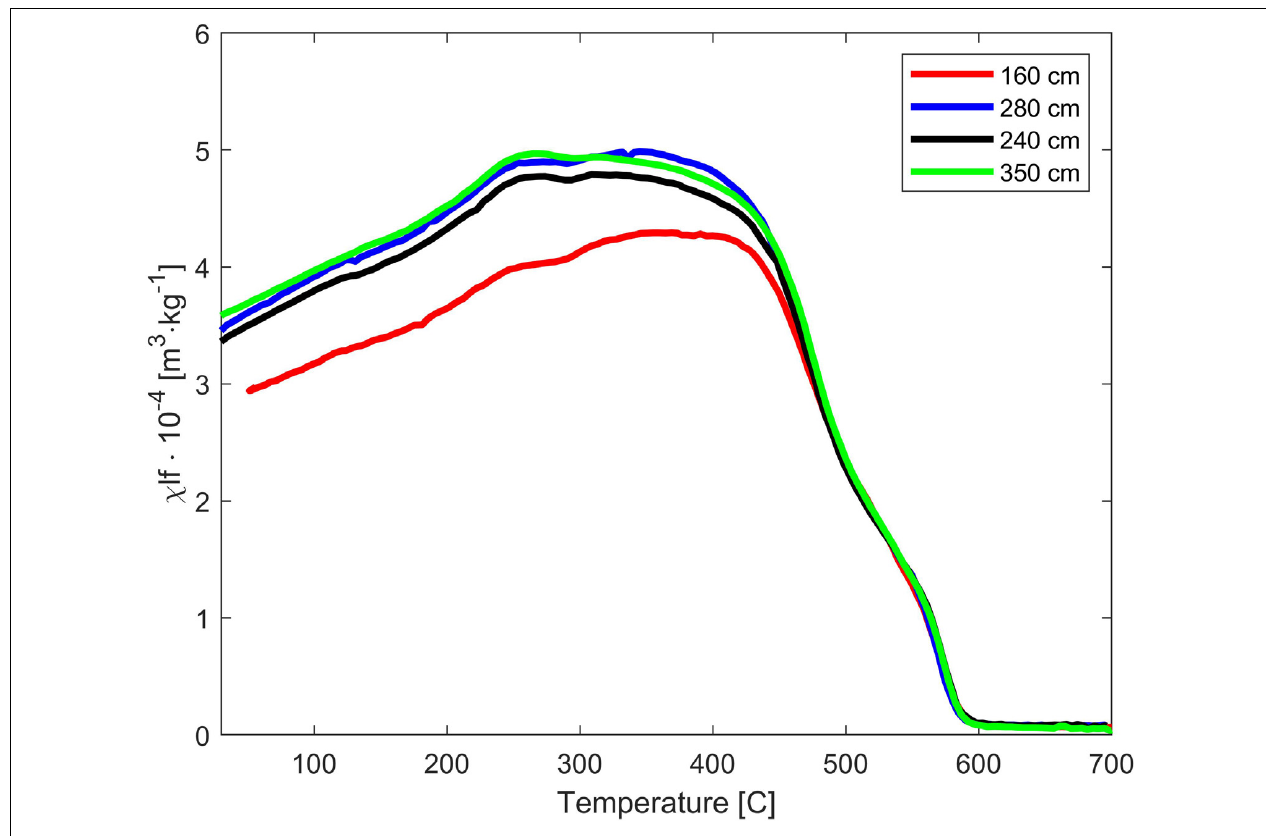
FIGURE 3 | Susceptibility thermomagnetic heating